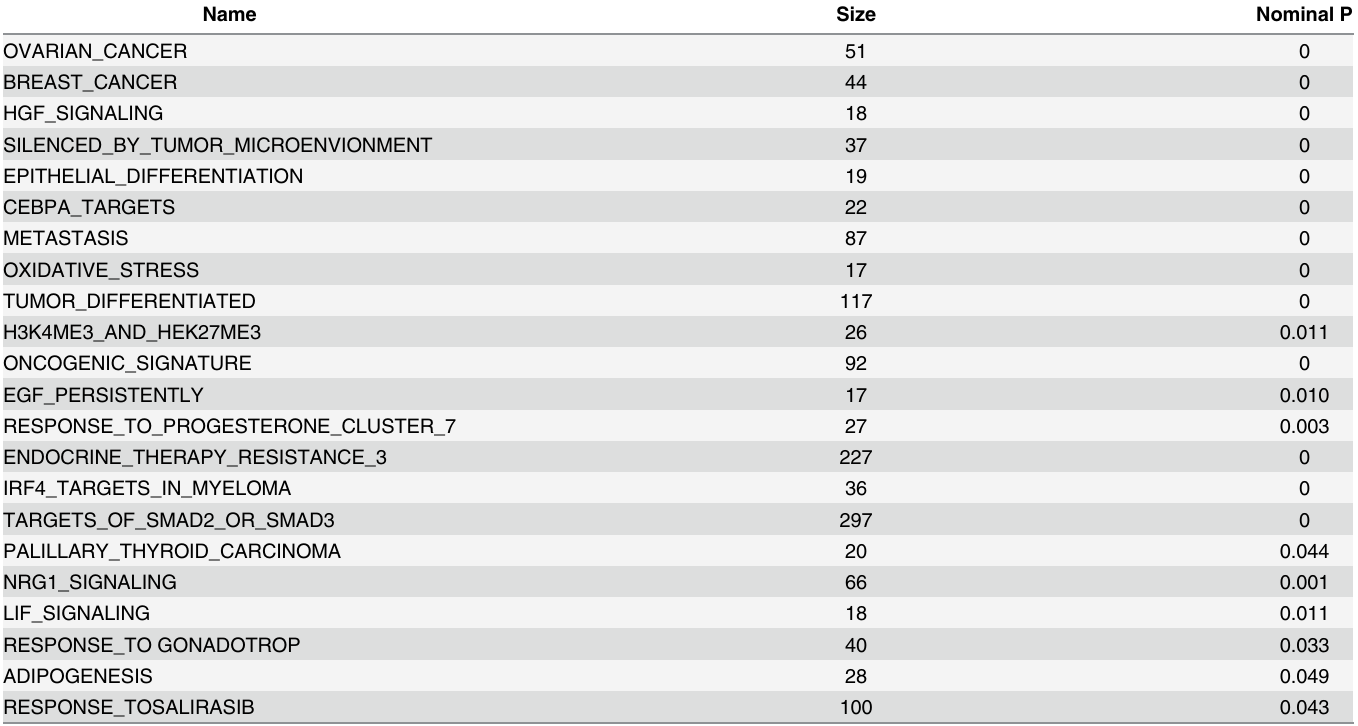
Table 1. The list of 22 down-regulated gene sets in the endometrium of patients with RIF.